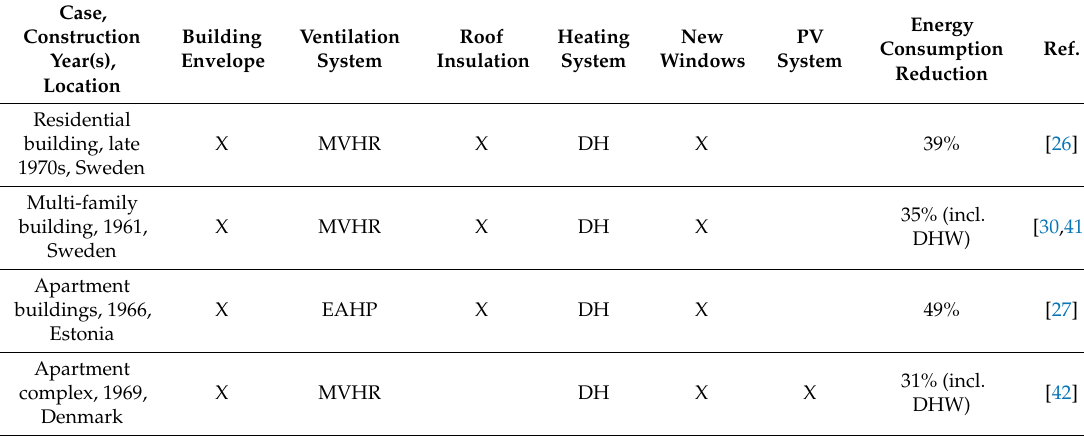
Table 1. The results of the performed renovation measures in studies that investigate the e ff ects of energy renovation on IAQ in a cold climate. All the case buildings were connected to district heating and the renovations included thermal improvements to the building envelope, new windows with better U -values and the installation of a heat recovery system. DH = district heating, MVHR = mechanical ventilation with heat recovery, EAHP = mechanical ventilation with an exhaust air heat pump, DHW = domestic hot water.